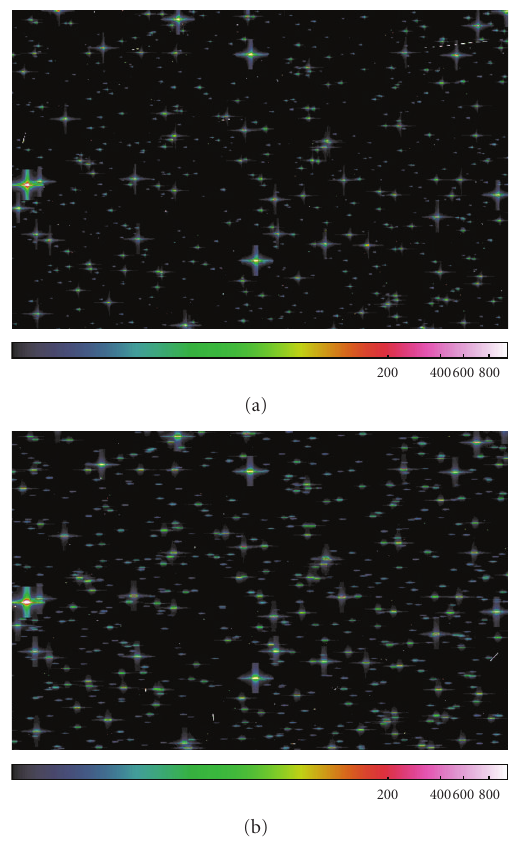
Figure 4: BP (a) and RP (b) images simulated by GIBIS simulator, the same sky field.